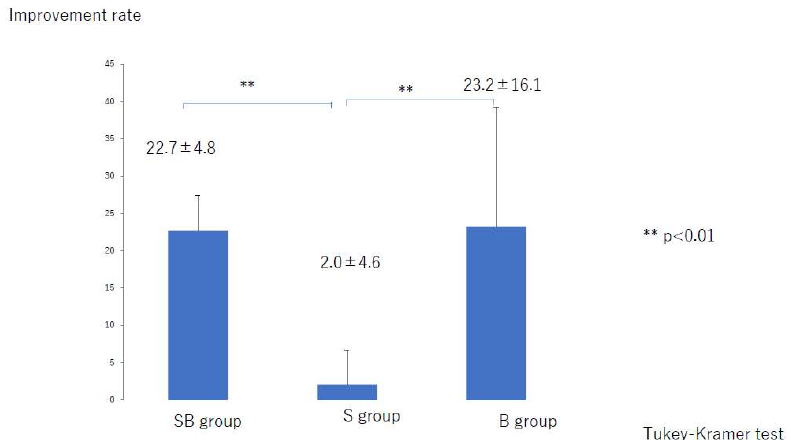
Figure 6. Rate of improvement in the lower extremity lymphedema index. B, bandage only; SB, compression stocking and bandage; S, stocking only.